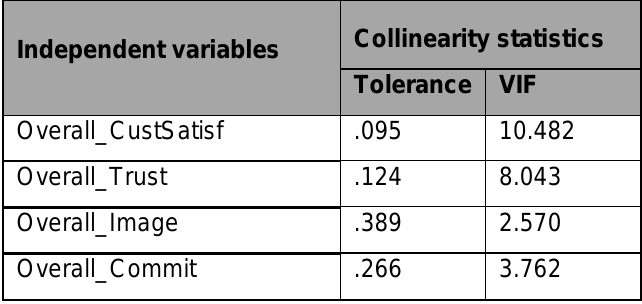
Table 2: Collinearity